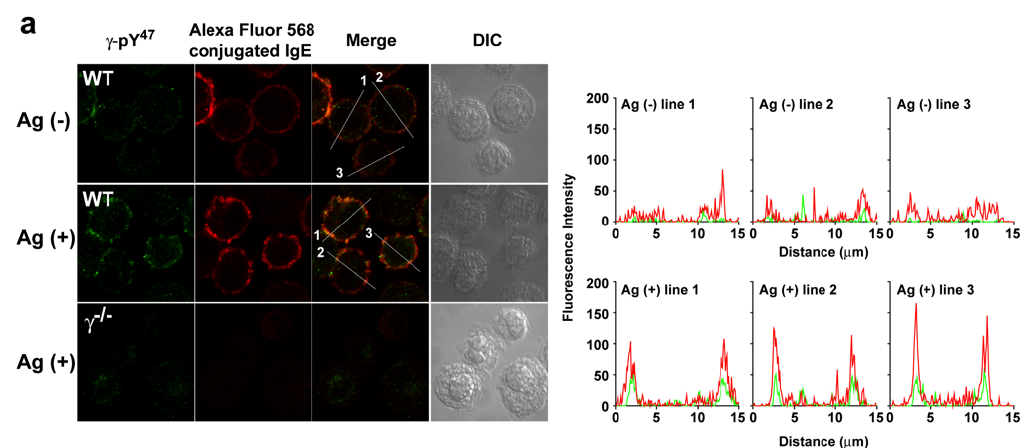
Figure 2. The γ -pY 47 antibody detects phosphorylation of Fc ε RI γ ITAM Y 47 in vitro and in vivo . ( a ) Single cell analysis of Fc ε RI γ ITAM Y 47 phosphorylation of mast cells stimulated with Ag for 1 min. Distribution of γ -pY 47 antibody was detected with Alexa Fluor 488 conjugated secondly antibody (green) and IgE was conjugated with Alexa Fluor 568 (red). An increased fluorescence intensity of Alexa Fluor 568 conjugated IgE was observed upon Fc  RI clustering following Ag stimulation. The merged images (yellow) indicate colocalization of γ -pY 47 antibody and Alexa Fluor 568 conjugated IgE. The fluorescence intensity in cross-section of individual cells is shown as an intensity plot. ( b ) Detection of Fc ε RI γ ITAM Y 47 phosphorylation in ear skin tissue of WT mice locally sensitized with saline or (anti-DNP) IgE in the contralateral ear. The next day, mice were challenged retroorbitally with Ag. Following a 5-min incubation, mice were euthanized, tissue collected and double whole-mount immunostaining was done with γ -pY 47 antibody (green) and Alexa Fluor 647 avidin (for mast cell staining).Mice sensitized with saline and subsequently challenged with Ag showed no detectable fluorescencewith γ -pY 47 antibody in tissues (data not shown). ( c ) Human blood from healthy donors was stimulated with anti-human IgE antibody for 2 min and then cells were fixed and stained for the surface markers, APC-conjugated anti-human CD123, PE-conjugated anti-human CD303, Pacific Blue-conjugated anti-human Fc ε RI α , and PercPCy5.5-conjugated anti-human CD203c, followed by intracellular staining with Alexa Fluor 488 conjugated γ -pY 47 antibody.Mean fluorescence intensity (MFI) for non-stimulated or anti-IgE stimulated (2 min) conditions was 228 and 269, respectively. ( d ) γ -pY 47 antibody can be used to determine the activation status of basophils in human blood from subjects with active SLE. Representative data from 4 healthy and 4 SLE subjects is